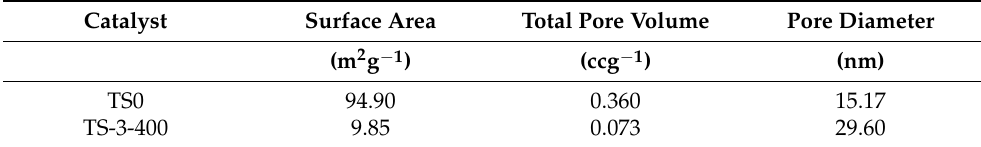
Table 5. Textural properties of catalysts TS0 and TS-3-400.